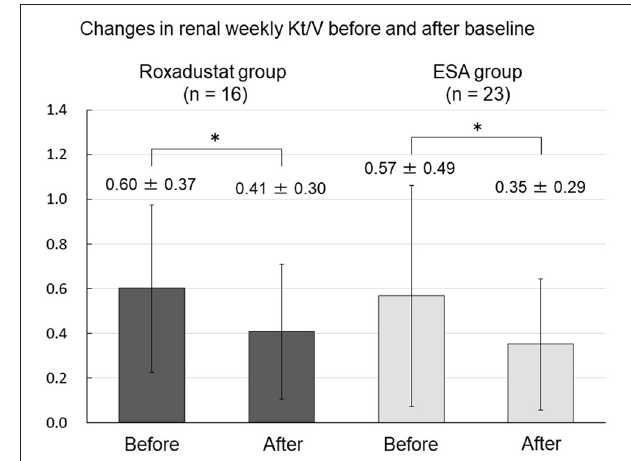
FIGURE 9 | Changes in 4-h dialysate/plasma creatinine before and after baseline in the Roxadustat and ESA groups. ESA, erythropoiesis-stimulating agent; NS, not significant.